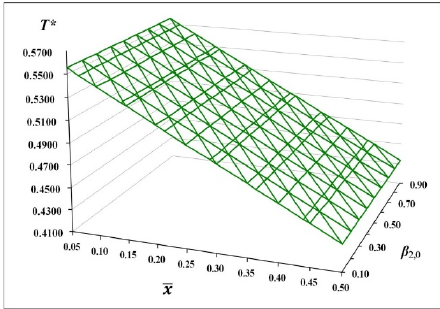
Fig. 14. Behavior of the optimal T * relating to the collective effect from x and